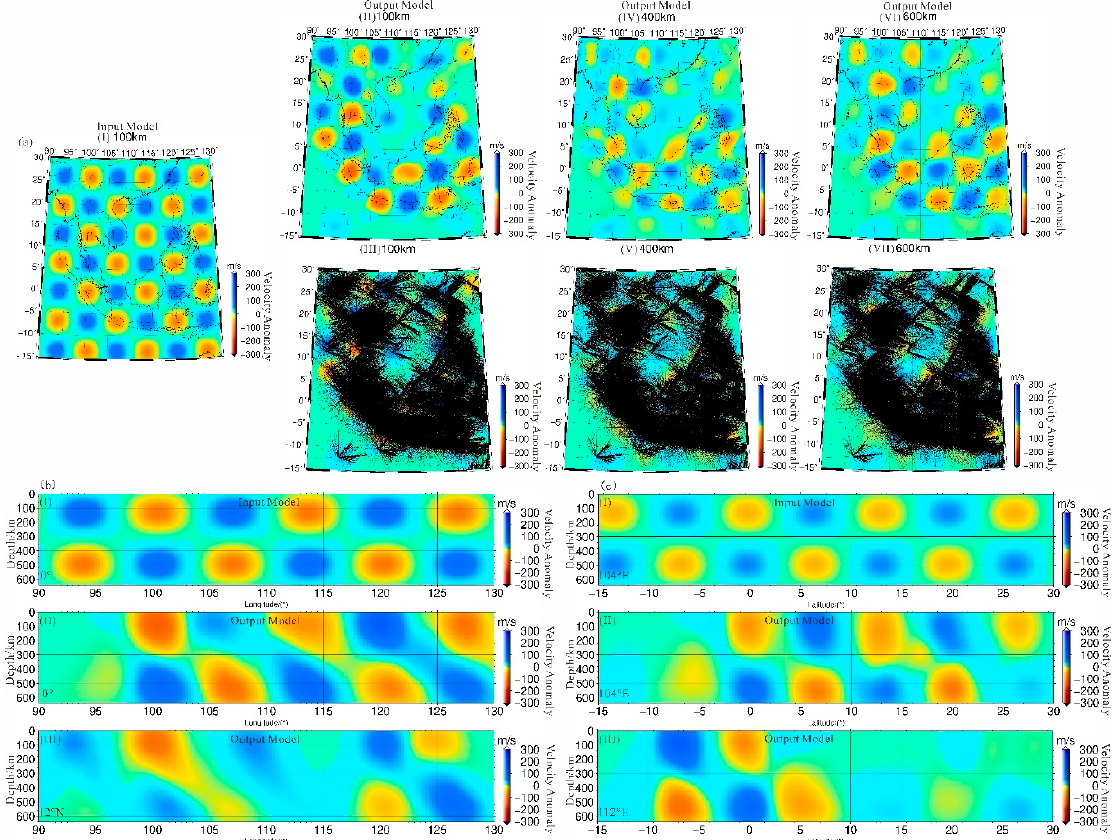
Figure 9. Results of checkerboard test in three directions and ray paths. ( a ) Horizontal slices; ( b )Vertical slices along east–west direction; ( c )Vertical slices along the north–south direction.